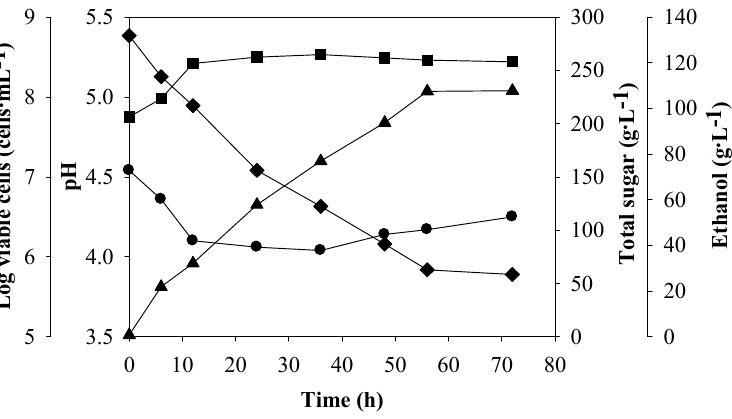
Figure 1. Batch ethanol fermentation of Run 1 from the synthetic medium containing 280 g·L − 1 of total sugar supplemented with yeast extract, 1; DSY, 4 and glycine, 1 g·L − 1 : log viable cells ( ■ ), pH ( ● ), total sugar ( ♦ ) and ethanol ( ▲